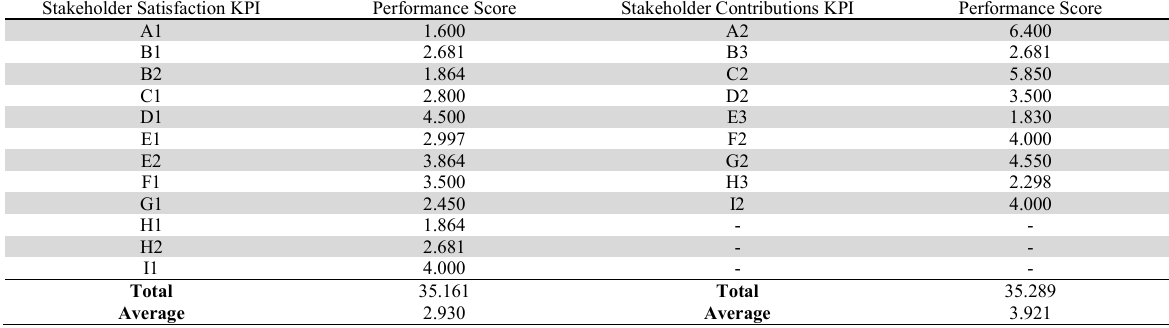
Table 5 Recapitulation of KPI Performance of Stakeholder Satisfaction and Contributions Stakeholder Satisfaction KPI Performance Score Stakeholder Contributions KPI Performance Score